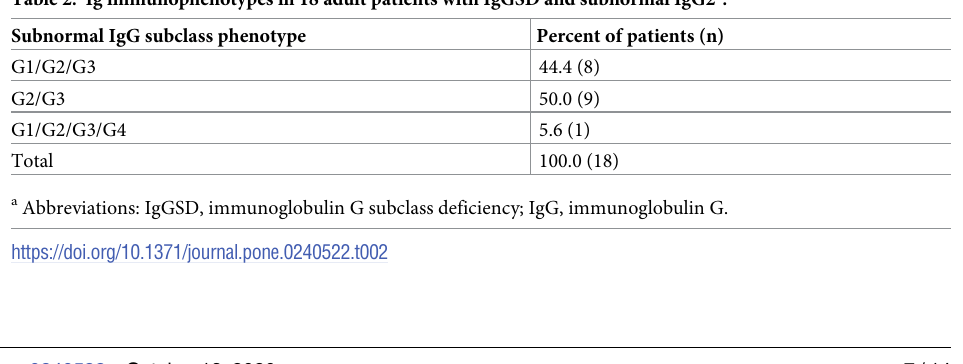
Table 2. Ig immunophenotypes in 18 adult patients with IgGSD and subnormal IgG2 a